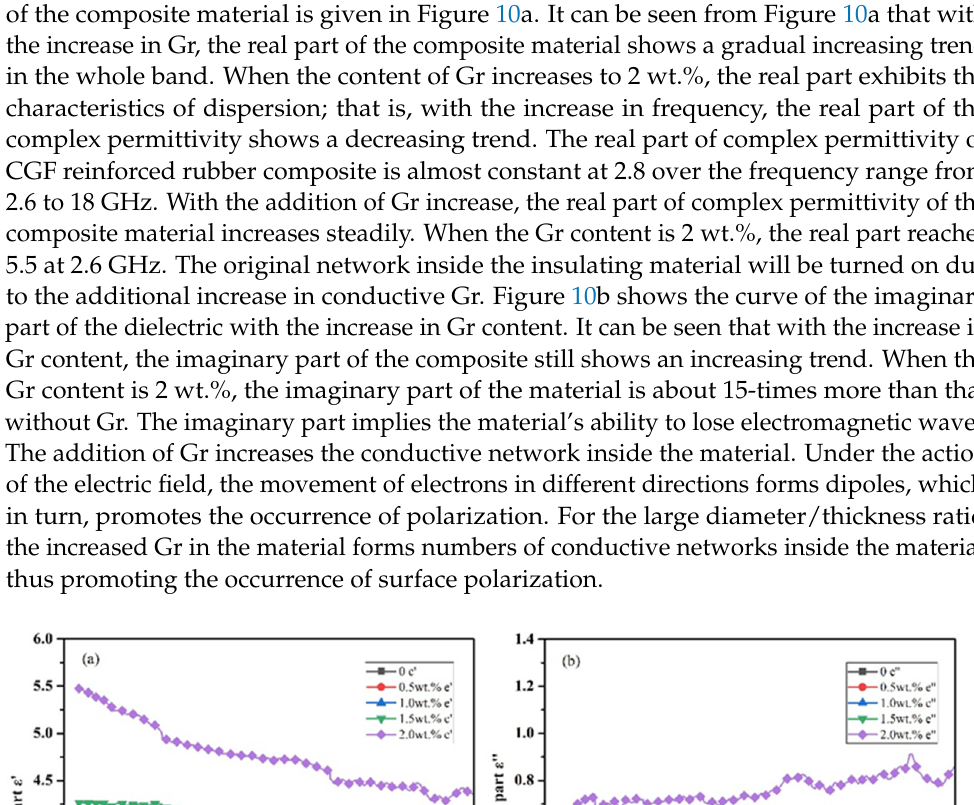
Figure 9. Schematic diagram of material anisotropy.